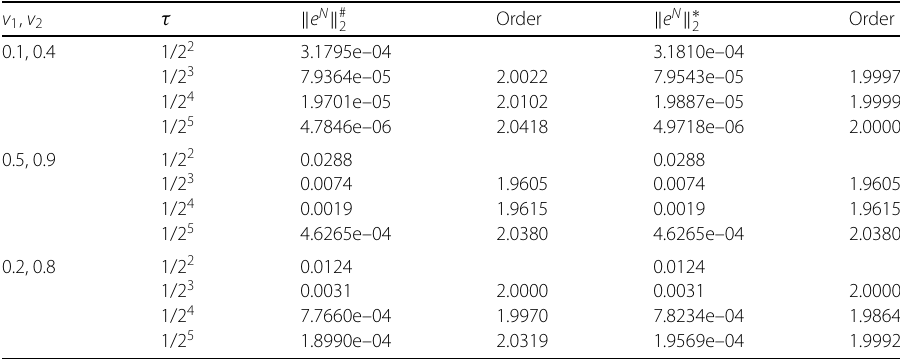
Table 1 The discrete L 2 error and convergence rates in time for schemes (8) and (16) for Example 1 with h = π /900 and (cid:3)α = 1/300 v 1 , v 2